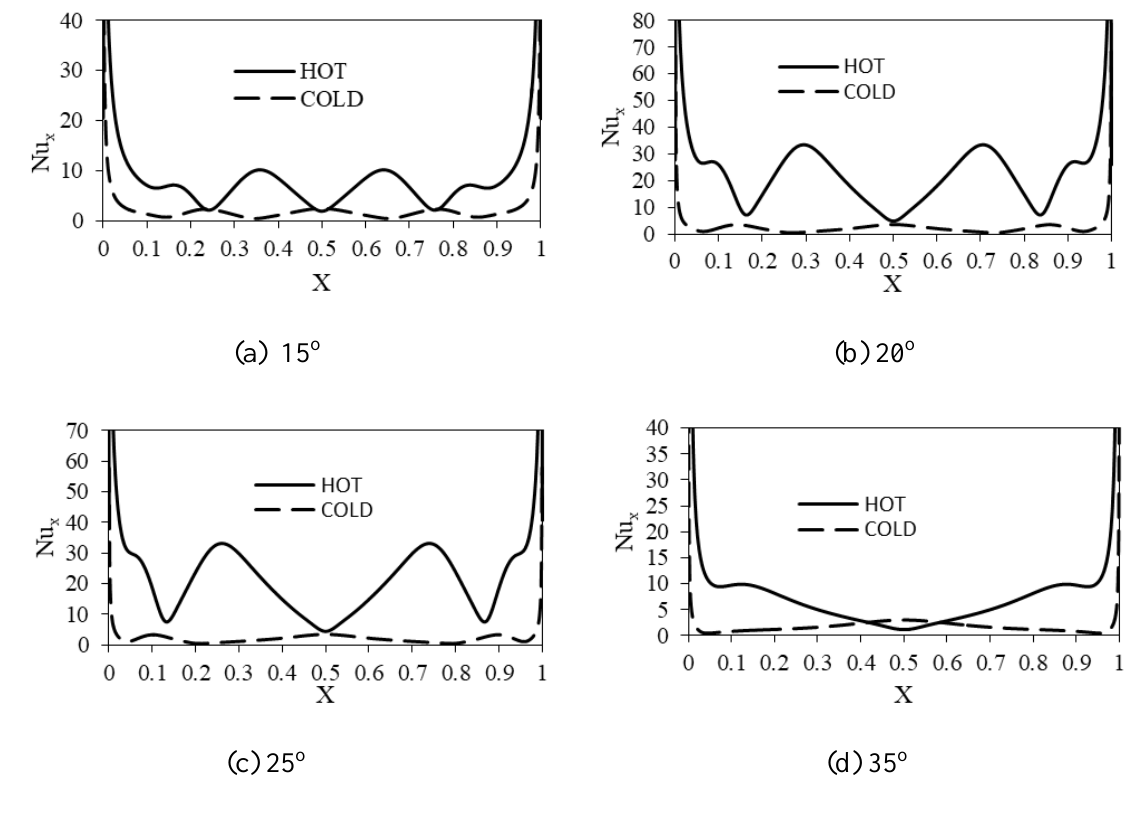
Fig. 10. Local Nu plots for different roof pitch